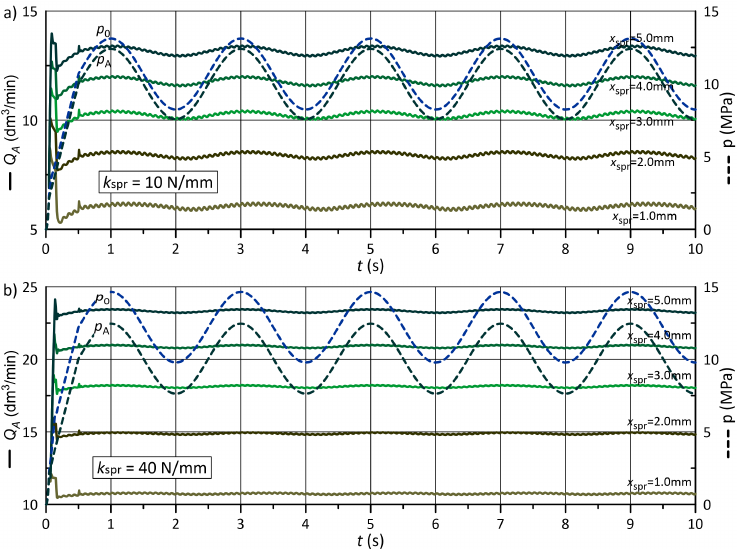
Figure 16. Valve flow rate obtained with sinusoidally varying load line pressure: ( a ) soft spring ( k spr = 10N mm − 1 ), ( b ) rigid spring ( k spr = 40N mm − 1